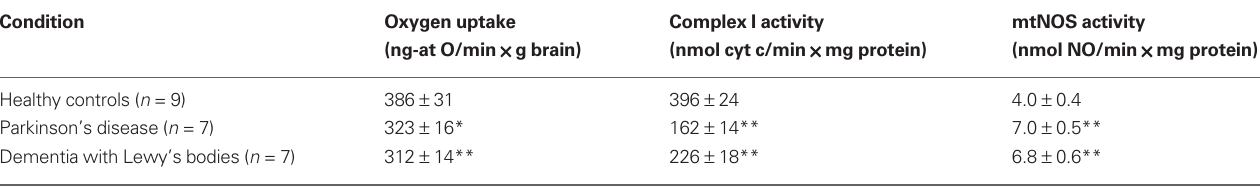
Table 1 | Oxygen uptake and complex I and mtNOS activities of human brain cortex in healthy controls and in patients with Parkinson’s disease or with dementia with Lewy